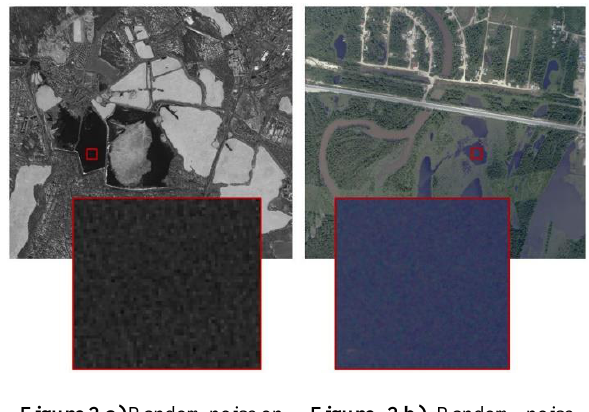
Figure 2.b) Random noise on an image obtained by airborne mapping camera DMC